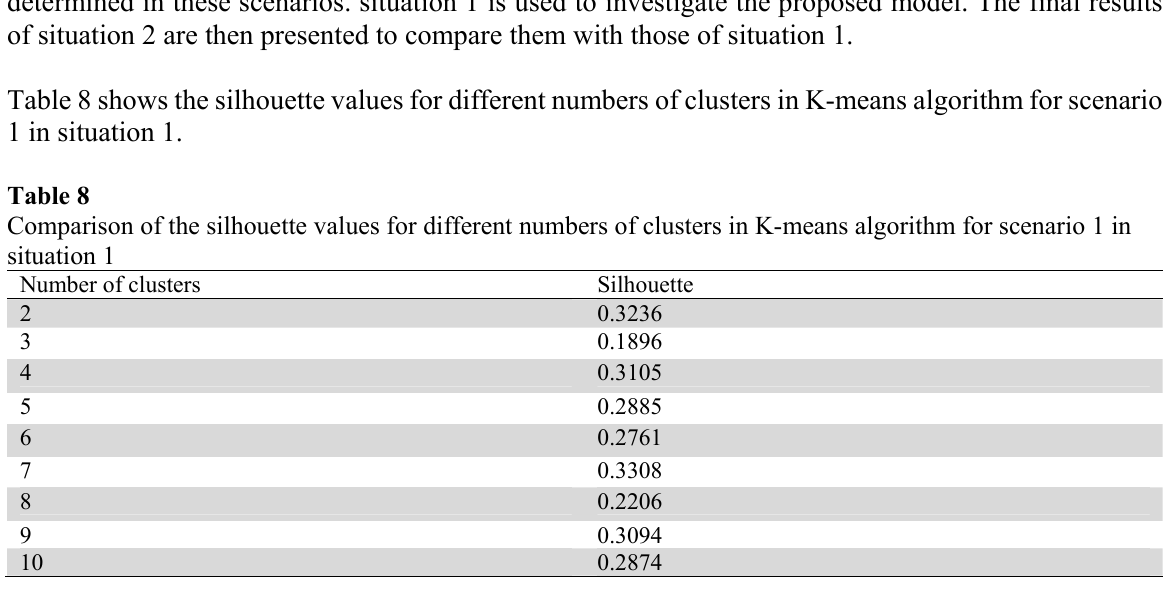
Table 9 indicates the silhouette value and the number of clusters for the K-means, SPSS Two-Step, and Kohonen SOM clustering algorithms for scenario 1 in situation